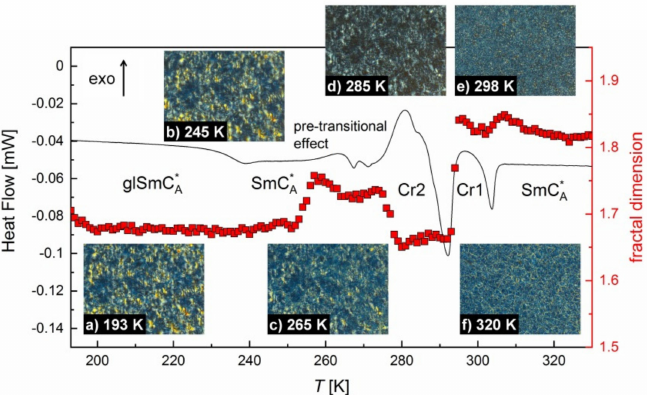
Figure 3. ( a – f ) POM textures of 3F7FPhH6 collected during heating at the 2 K/min rate with the results of the fractal box count numerical analysis (squares) and DSC curve (line) registered with the same